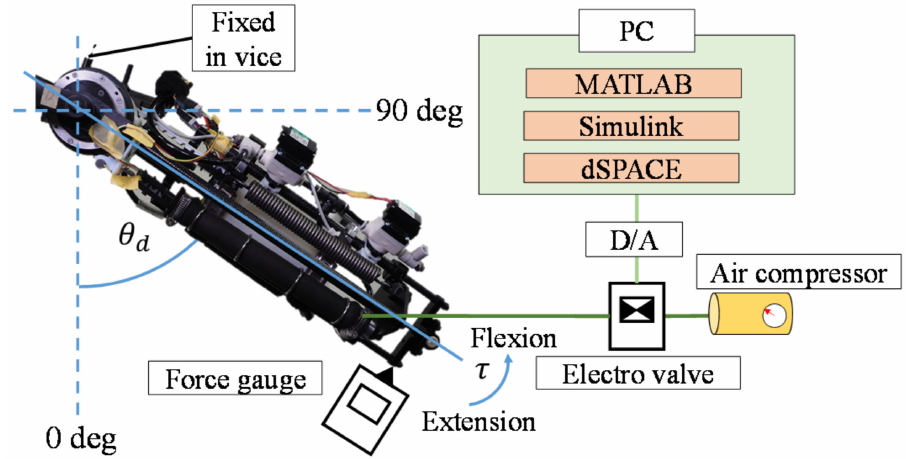
Figure 8. Experimental environment of basic characteristics